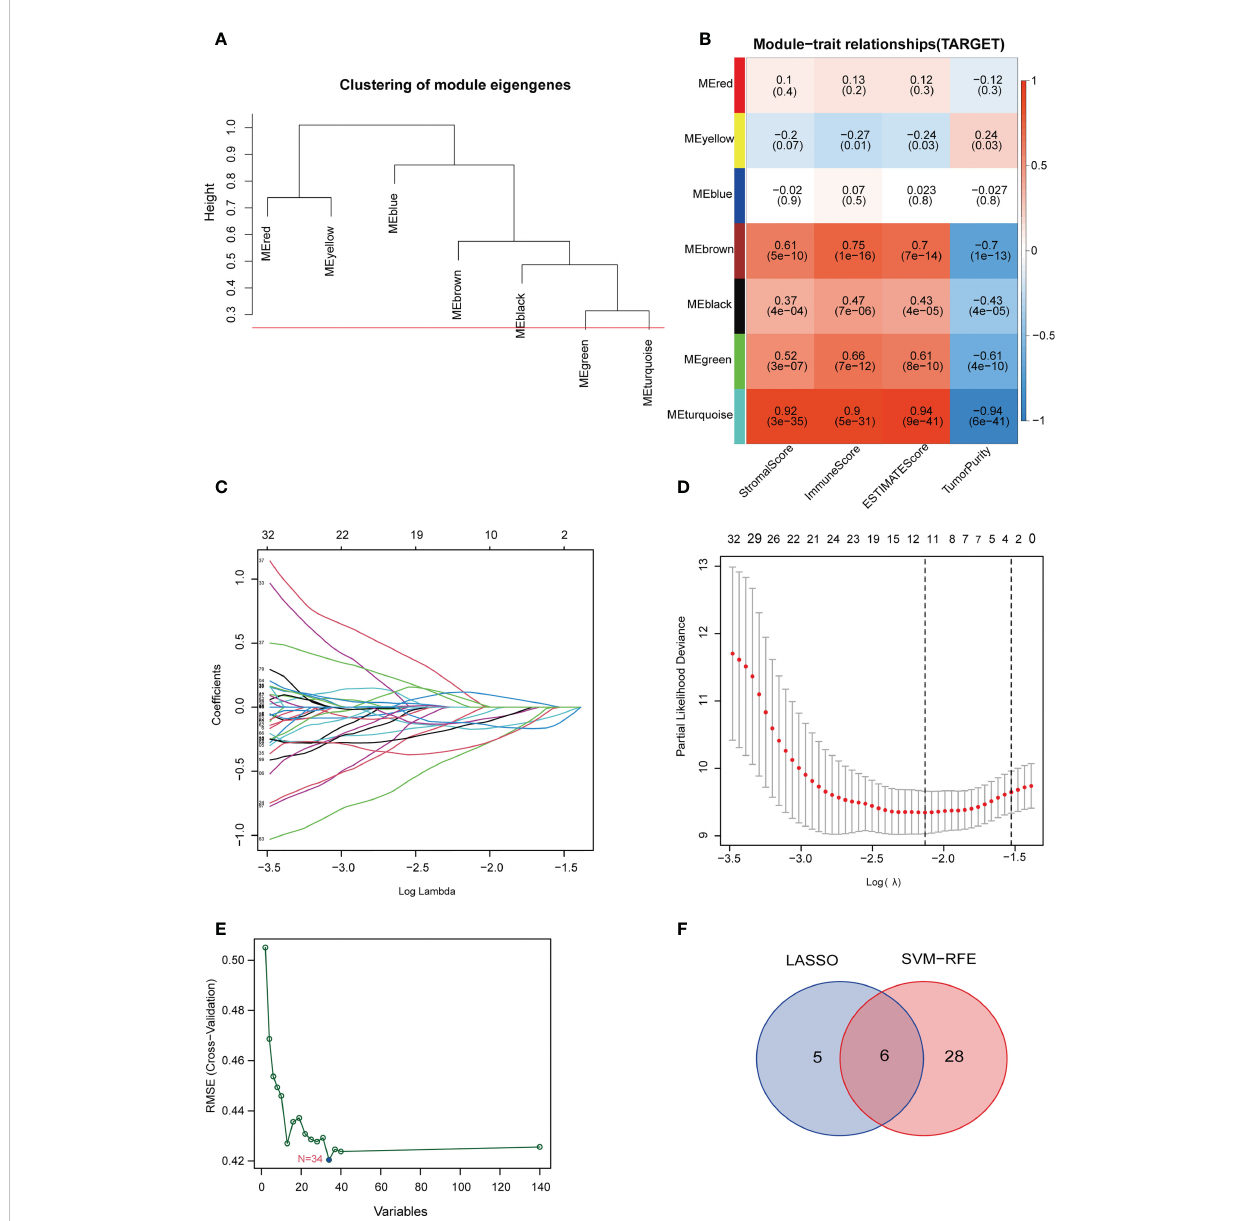
FIGURE 3 Construction of the TILscore. (A) Module thresholds for WGCNA analysis. (B) Coef fi cients of different modules showing the correlation of TILs marker genes with 4 microenvironment scores. (C, D) Coef fi cient and parameter plots of LASSO analysis showing the 11 fi ltered candidate genes and pathways of TILs marker genes. (E) Machine learning SVM analysis curve showing 34 fi ltered candidate genes. (F) Venn diagram of common candidate genes from LASSO analysis and machine learning SVM